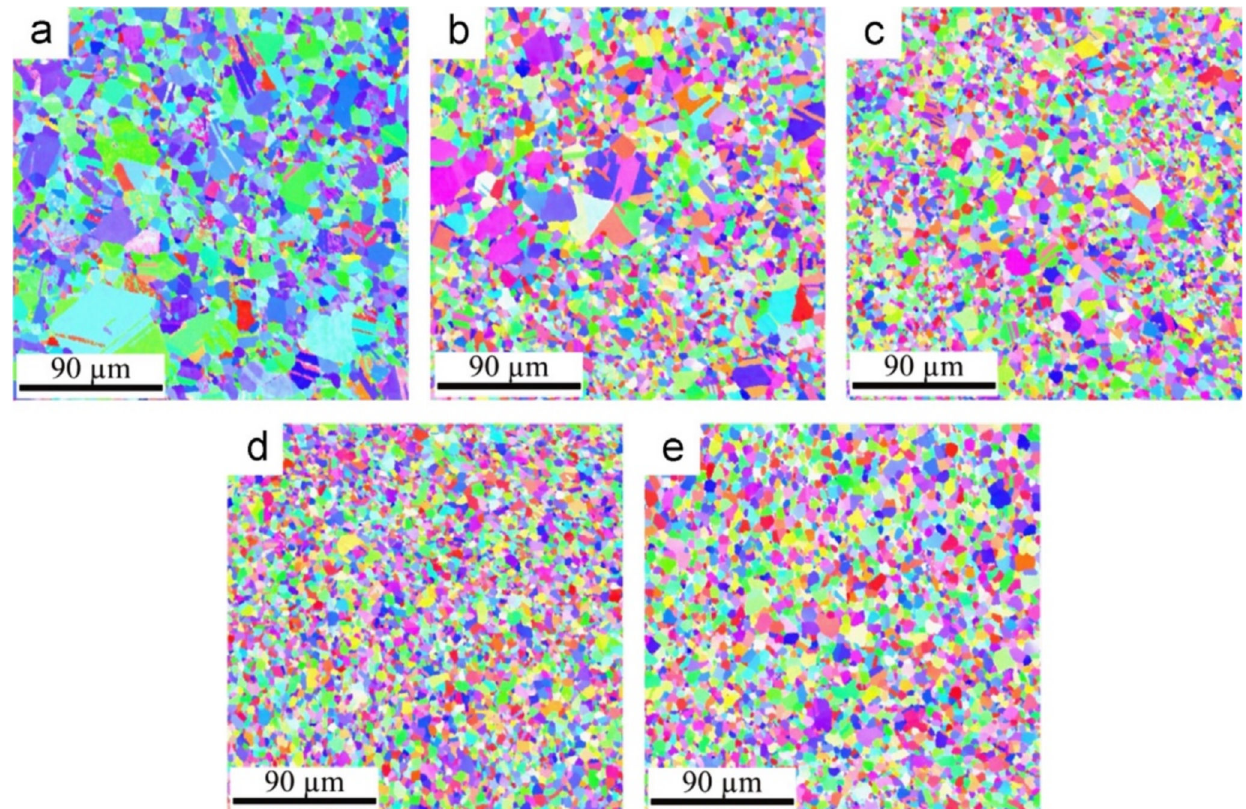
Figure 13. Inverse pole figure (IPF) maps obtained by EBSD for the sintered samples: ( a ) Pure Ni, ( b ) MWCNT/Ni 6.5 vol.%, ( c ) MWCNT/Ni 12 vol.%, ( d ) MWCNT/Ni 18 vol.%, and ( e ) MWCNT/Ni 27 vol.%. Reproduced from [88] with permission from Elsevier,